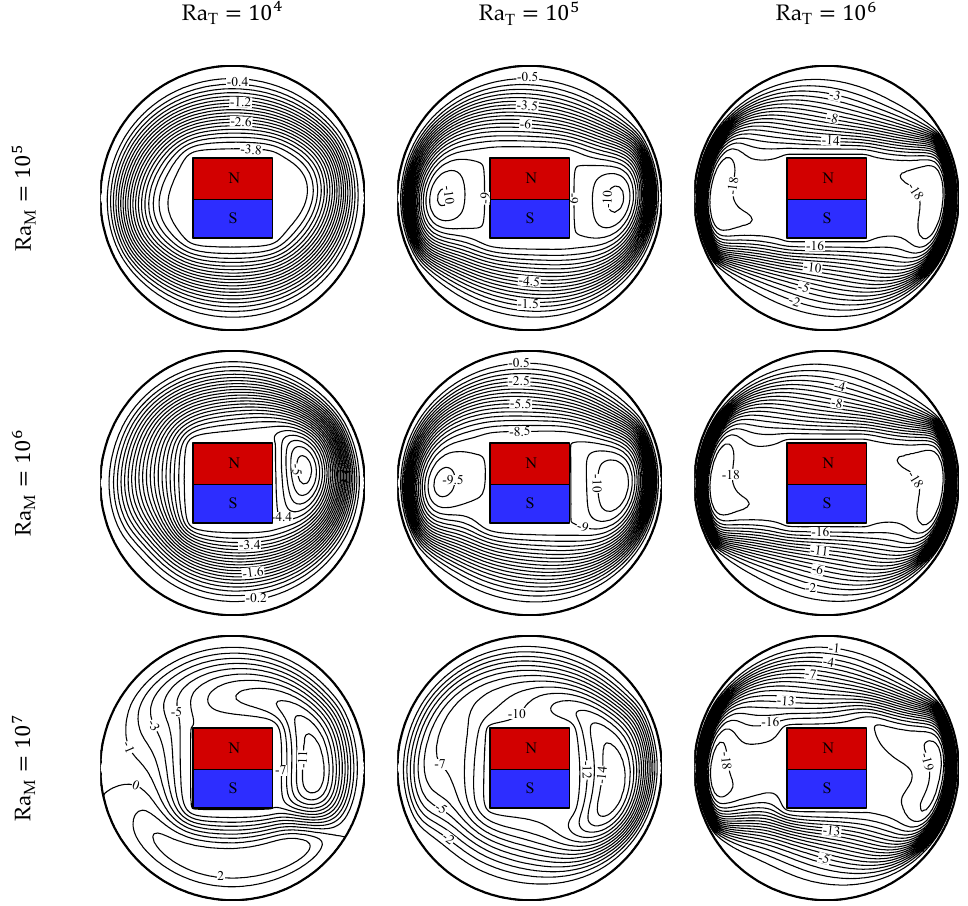
Figure 8. Dependence of the streamlines on the Ra T and, Ra M when n = 0.8, λ = 0.0, Pr = 100, Ma = 10 − 4 , β c = 60, δ = 30 ◦ and L =